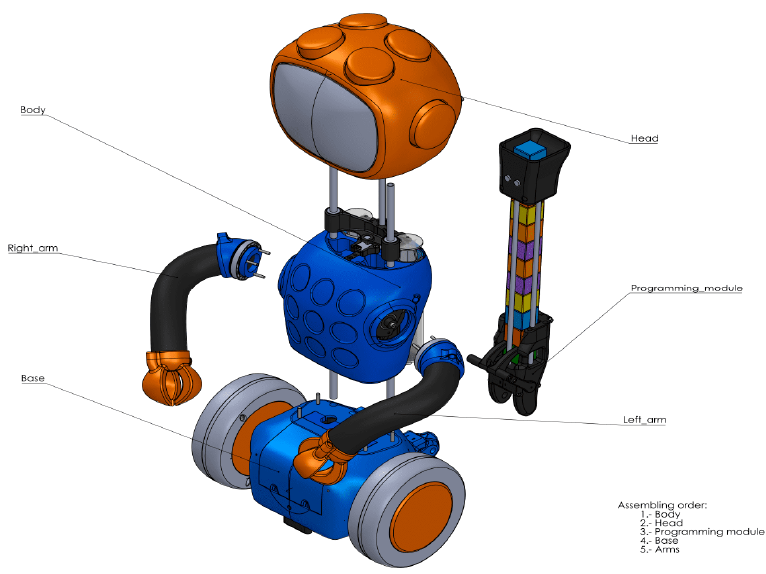
Figure 13. Main components of 3D Qui-Bot, LaCodornella (Assembling order: Body, Head, Programming module, Base, Left arm, Right arm) [33].